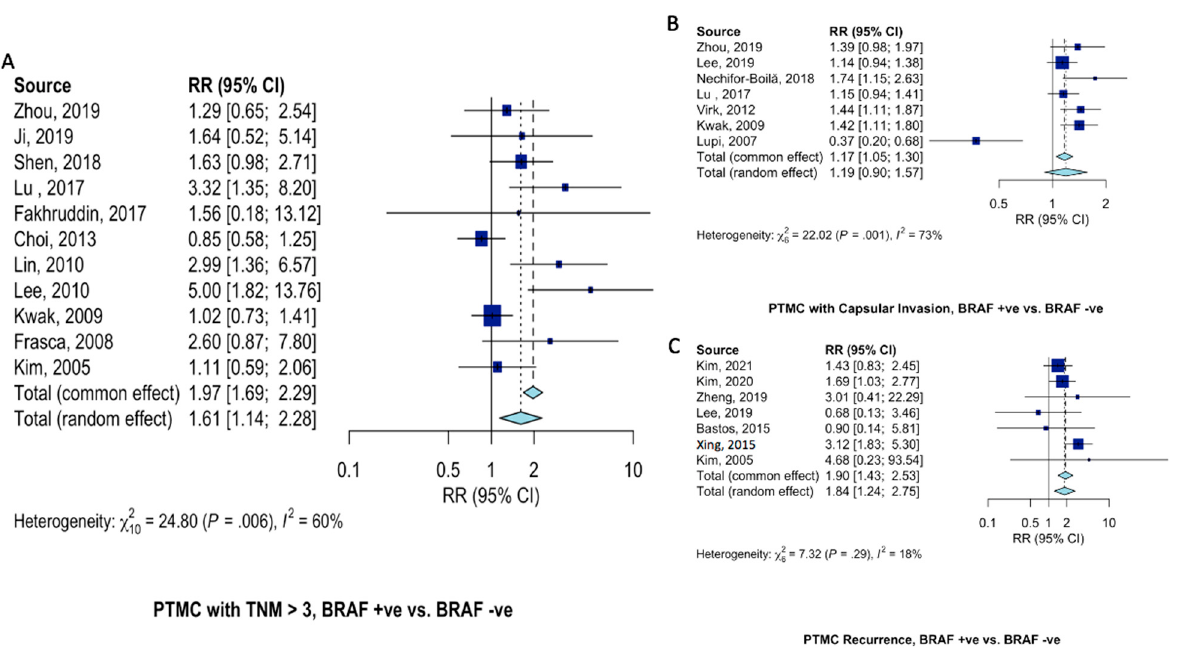
Figure 5. Pooled analysis of clinical characteristics in PTMC patients according to BRAF V600E gene mutation. Forest plots for ( A ) advanced (TNM > 3) disease stage [12,15,18,20,21,29,34,36,37,39,42], ( B ) capsular invasion [12,16,17,20,30,37,41], and ( C ) recurrence [10,11,13,16,24,25,42].